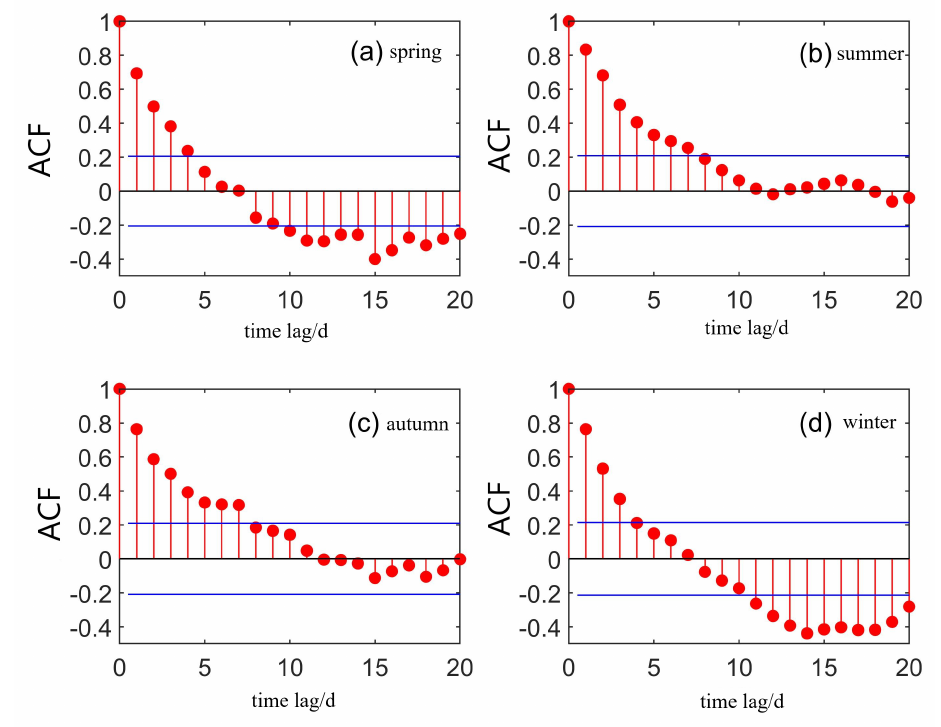
The autocorrelation function values of daily load in the four seasons are shown in Figure 7. The blue line in the figure represents the critical value of the 95% significance level of the autocorrelation function (the critical value is inversely proportional to the length of the time series). According to the length of the entire load sequence of the four seasons, we checked the critical value table of the correlation coefficient to determine the critical values to be 0.205, 0.209, 0.210, and 0.211. When the autocorrelation function value is greater than the critical value, it indicates that the time lag load is significantly correlated with the target period load; otherwise, the autocorrelation is not significant. The maximum time lag where the positive autocorrelation function value is greater than the critical value is taken as the pre-ordered autocorrelation load time lag. As a result, the pre-ordered autocorrelation load time lag is four days in spring, seven days in summer and autumn, and three days in winter.